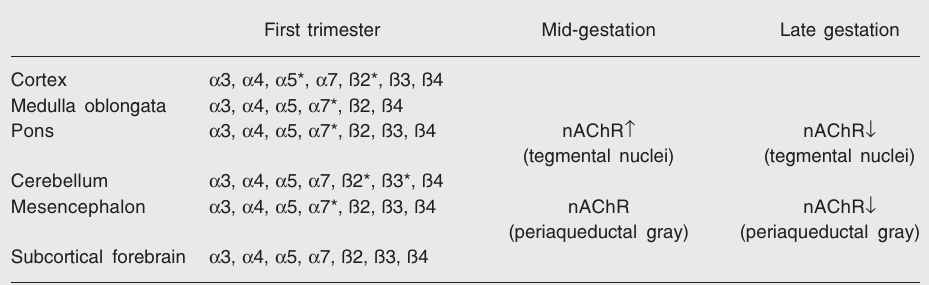
Table 2. Brain nicotinic acetylcholine receptor (nAChR) levels of human fetuses at different gestational